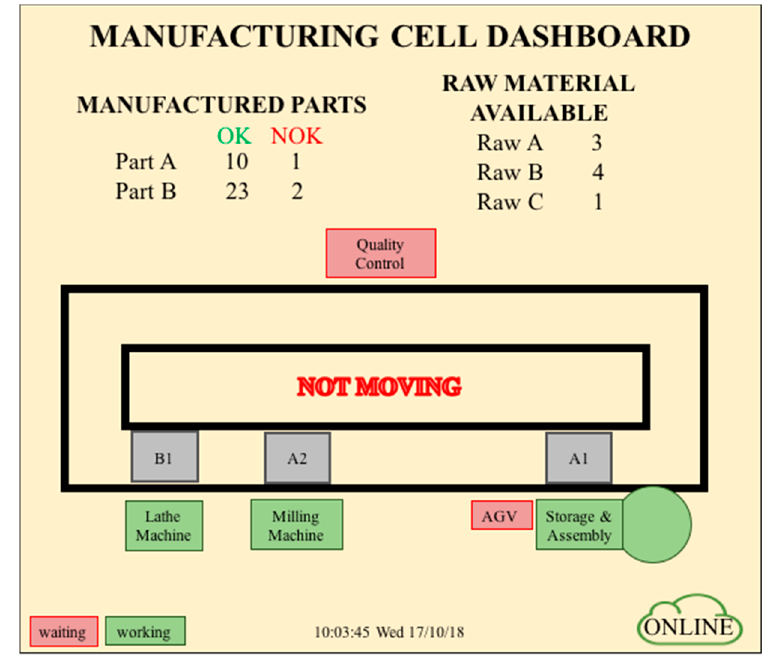
Figure 5. Example of a manufacturing cell dashboard.